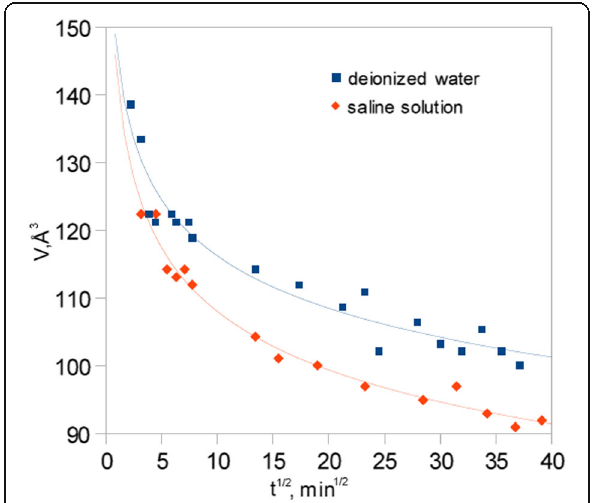
Fig. 7 Free volume holes evolution during dehydration process